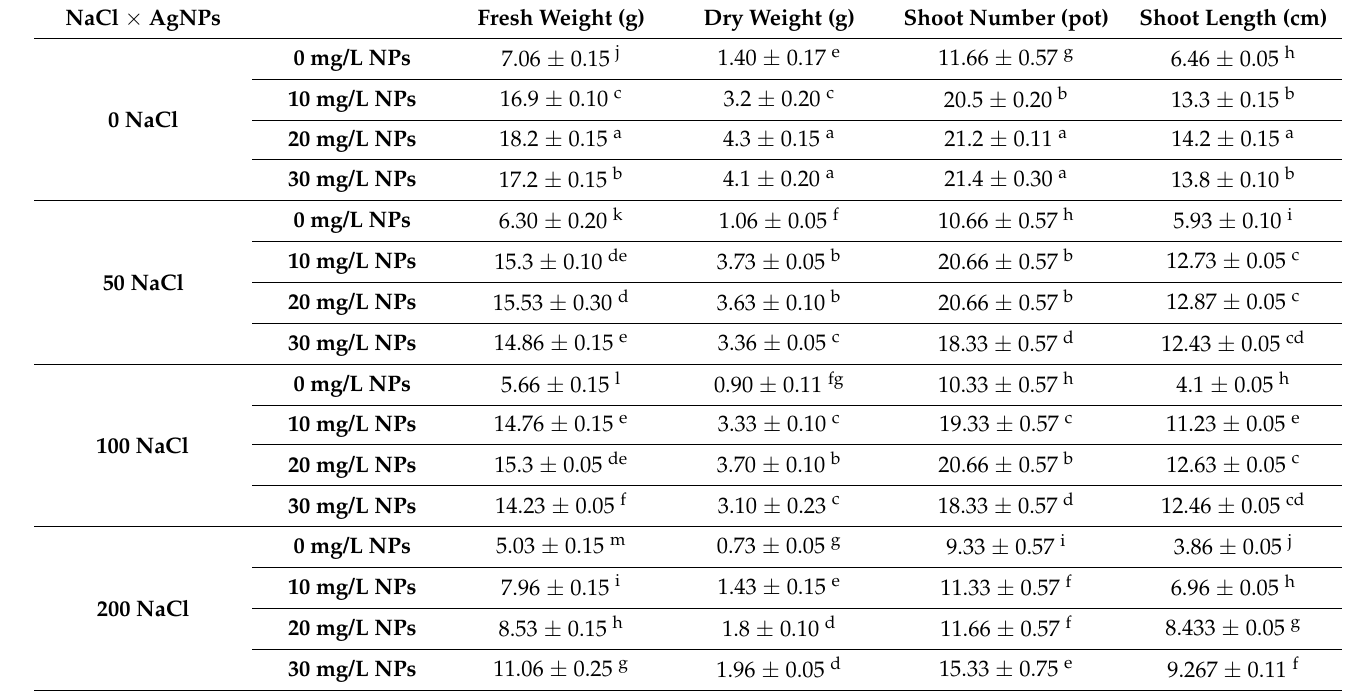
Table 1. Effect of silver nanoparticles on the in vitro regeneration of Maerua oblongifolia exposed to salt stress after 45 days of treatment in MS